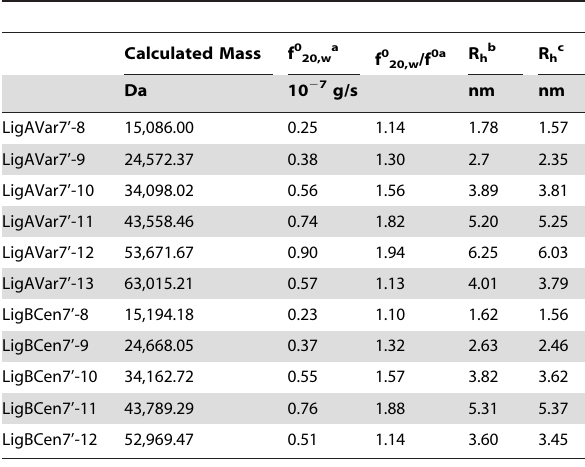
Table 5. Summary of hydrodynamic parameters of truncated Lig proteins in Tris pH 7.0 determined by AUC and